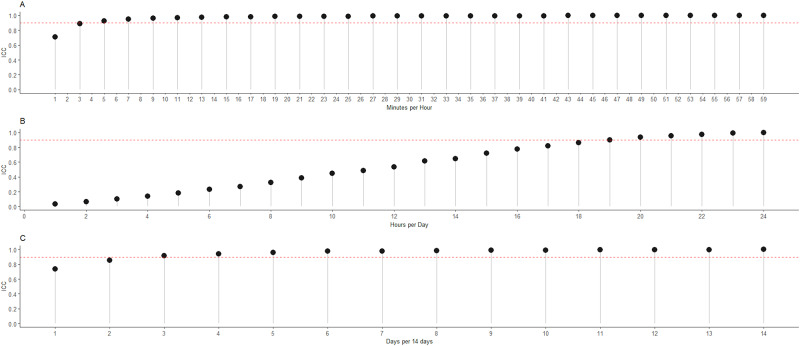
Intraclass correlations (ICC) for incrementally deleted data and ‘true’ data.Data are presented for scaled minutes per hour (A), for hours per day (B) and for number of days per 14 days (C).